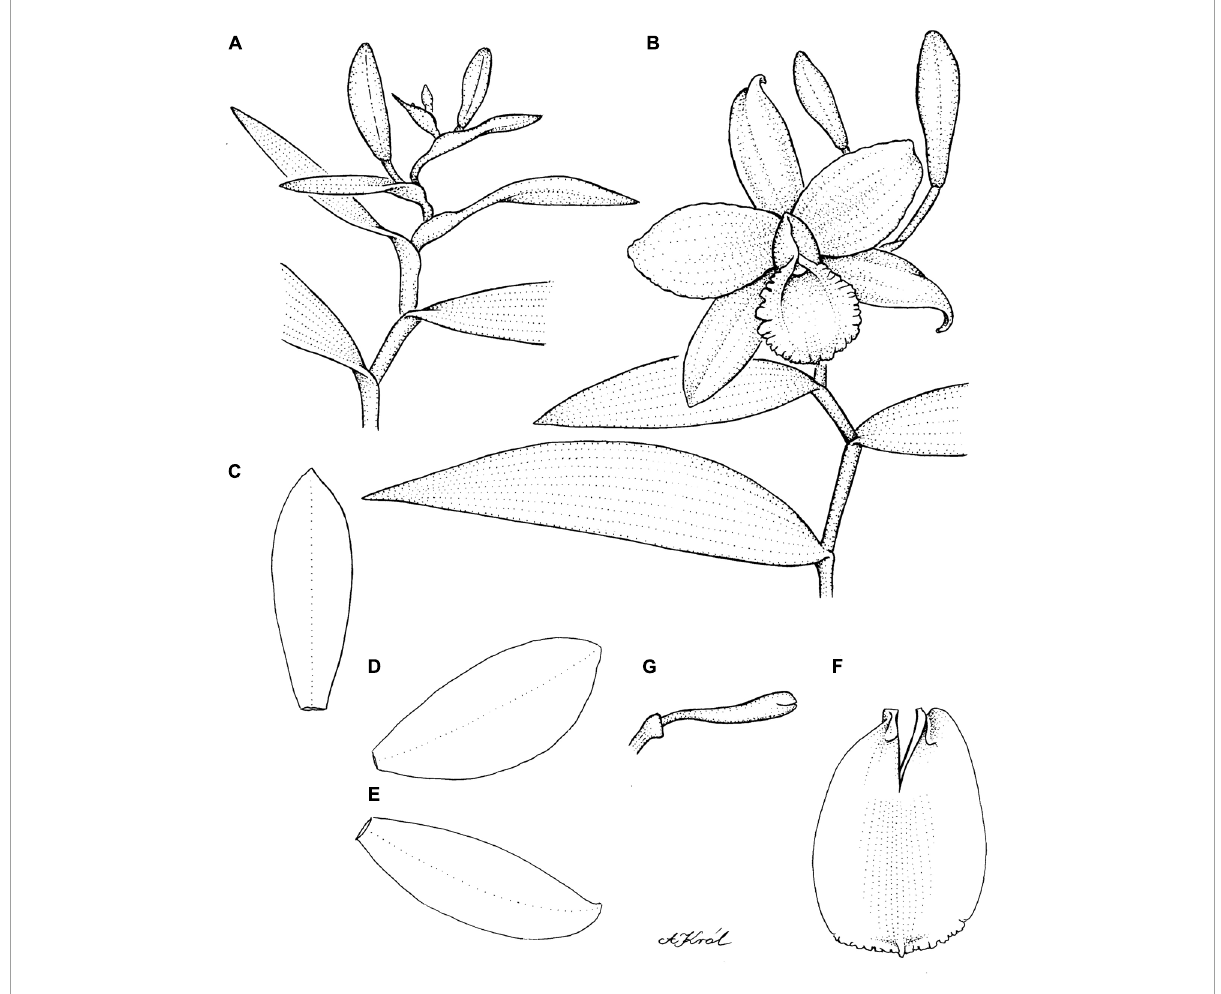
FIGURE1 Sobralia paradisiaca Rchb. f. (A,B) apical part of stem with the inflorescence, (C) dorsal sepal, (D) petal, (E) lateral sepal, (F) lip, and (G) gynostemium [redrawn by A. Król from Dunsterville and Garay